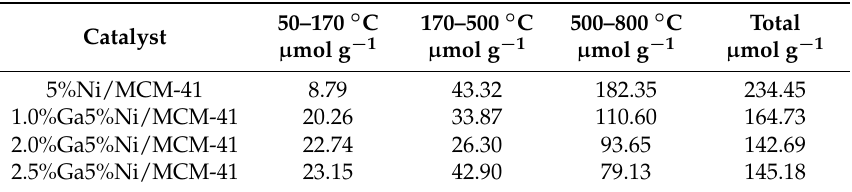
Figure 4. CO 2 -TPD profiles of 5%Ni+x%Ga/MCM-41. (x = 1.0, 2.0, 2.5).